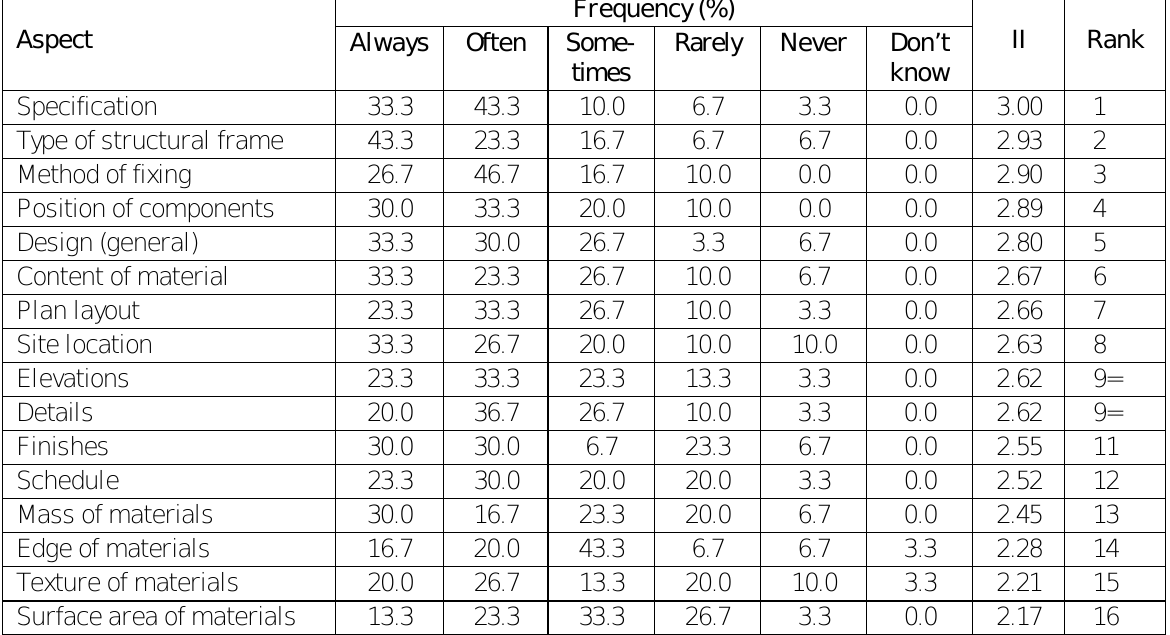
Table 4: Frequency at which PMs consider / refer to construction H&S relative to